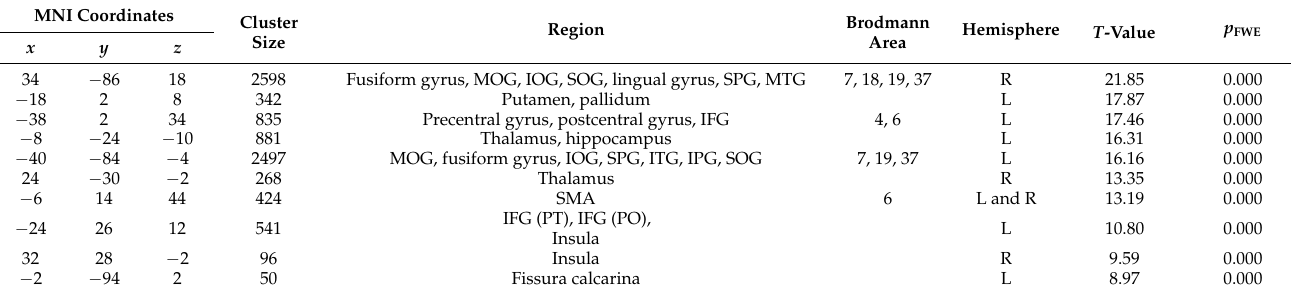
Figure 2. Brain activation in healthy subjects ( n = 12) while constructing grammatically and semanti- cally correct sentences in response to the novel language task, which comprised a combination of picture naming and simple verb generation ( T = 7, p < 0.001; uncorrected). Activation is depicted on a single-subject-normalized brain surface implemented in SPM8. Abbreviations: IFG—inferior frontal gyrus, SMG—supramarginal gyrus, AG—angular gyrus, pSTG—posterior superior temporal gyrus, MTG—middle temporal gyrus. Table 2. Brain activation in healthy subjects ( n = 12) while constructing grammatically and semantically correct sentences according to the language task, which comprised a combination of picture naming and simple verb generation ( T = 7, p < 0.001;